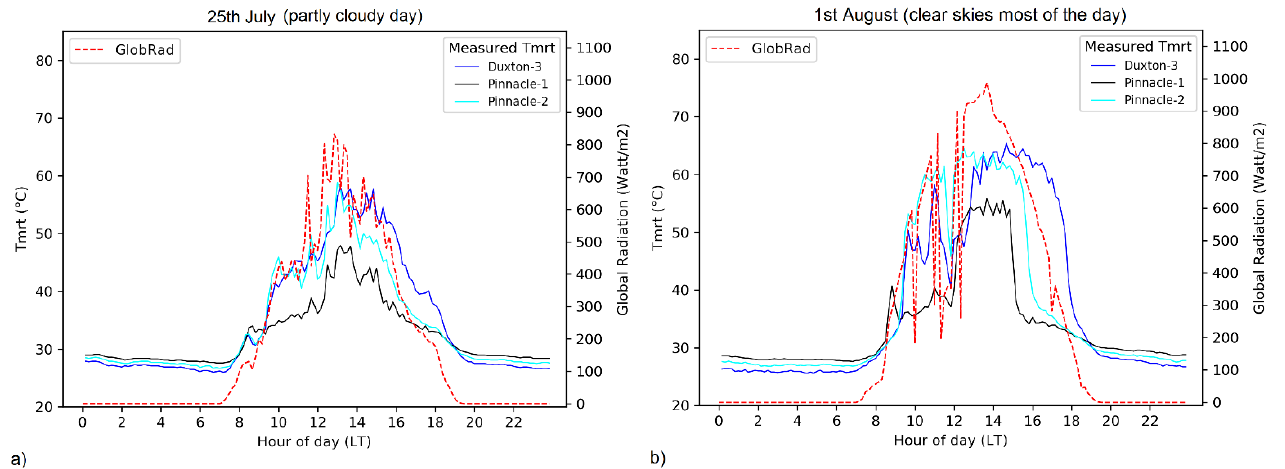
Figure 10. Diurnal cycle of T mrt (using 10-min averaged data) and global incoming solar irradiance (using 10-min values) in Duxton3, Pinnacle1, and Pinnacle2 on ( a ) 1 August 2019 (clear skies during most of the day) and ( b ) 25 July 2019 (partly cloudy day).